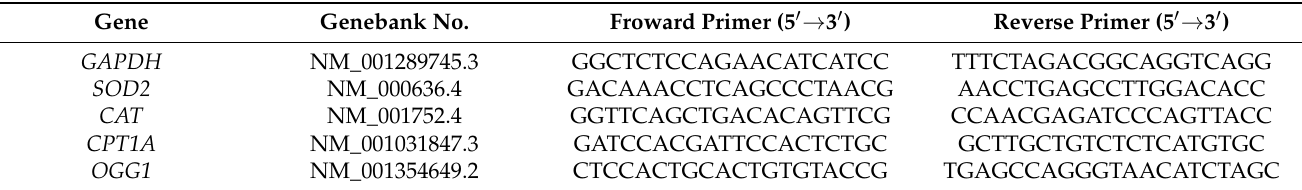
Table 1. Primer sets used in quantitative